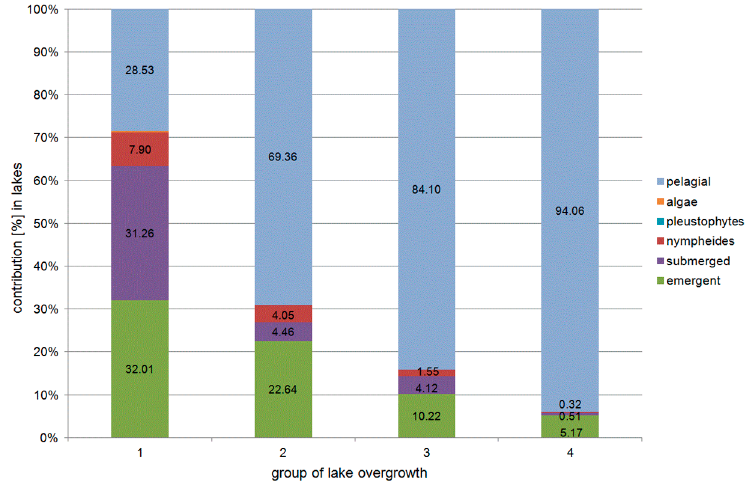
Figure 3. Contribution of growth of different forms of macrophytes and pelagic zone in the lakes between analyzed groups of overgrowing lakes (1—the highest, 4—the lowest).